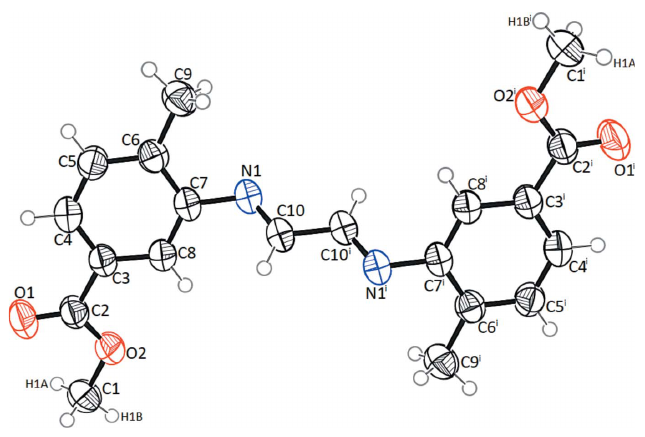
Figure 1 The molecular structure of the title compound, showing the atom labelling. Displacement ellipsoids are drawn at the 40% probability